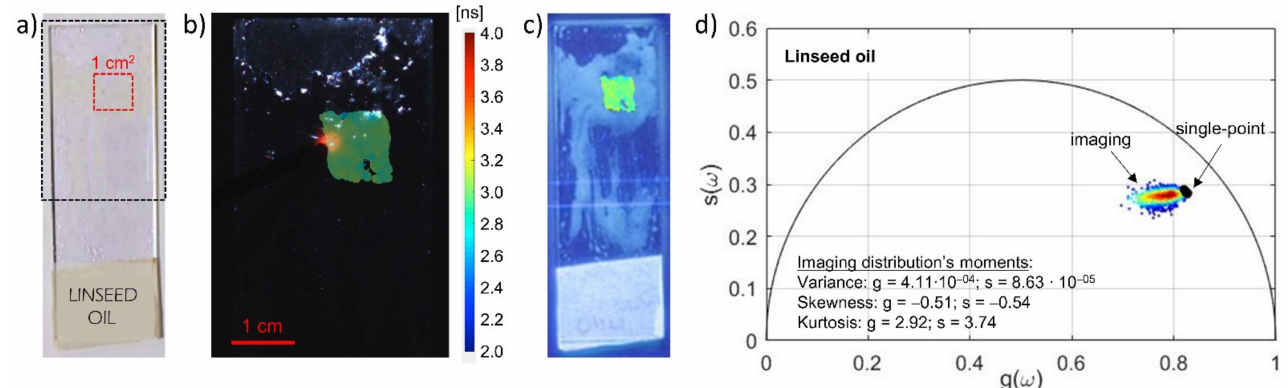
Figure 2. Imaging and single-point FL analysis of an LO sample. ( a ) Bright-field image of the sample, i.e., linseed oil spread on a microscope slide (the red dashed square indicates the region where measurements were acquired, while the black dashed rectangle shows the area magnified in ( b ), as seen by the CCD camera of the FL instrument working in imaging mode. ( b ) Detail of the sample showing the fluorescence lifetime map in color-coded scale obtained in imaging mode (color bar corresponding to the τ -phase values); the red spot is from the aiming beam. ( c ) The same lifetime map superimposed on the linseed oil sample, illuminated with a low-pressure mercury lamp. ( d ) Phasor diagram showing the distribution of phasors calculated from the imaging and the single-point modes on the same area.